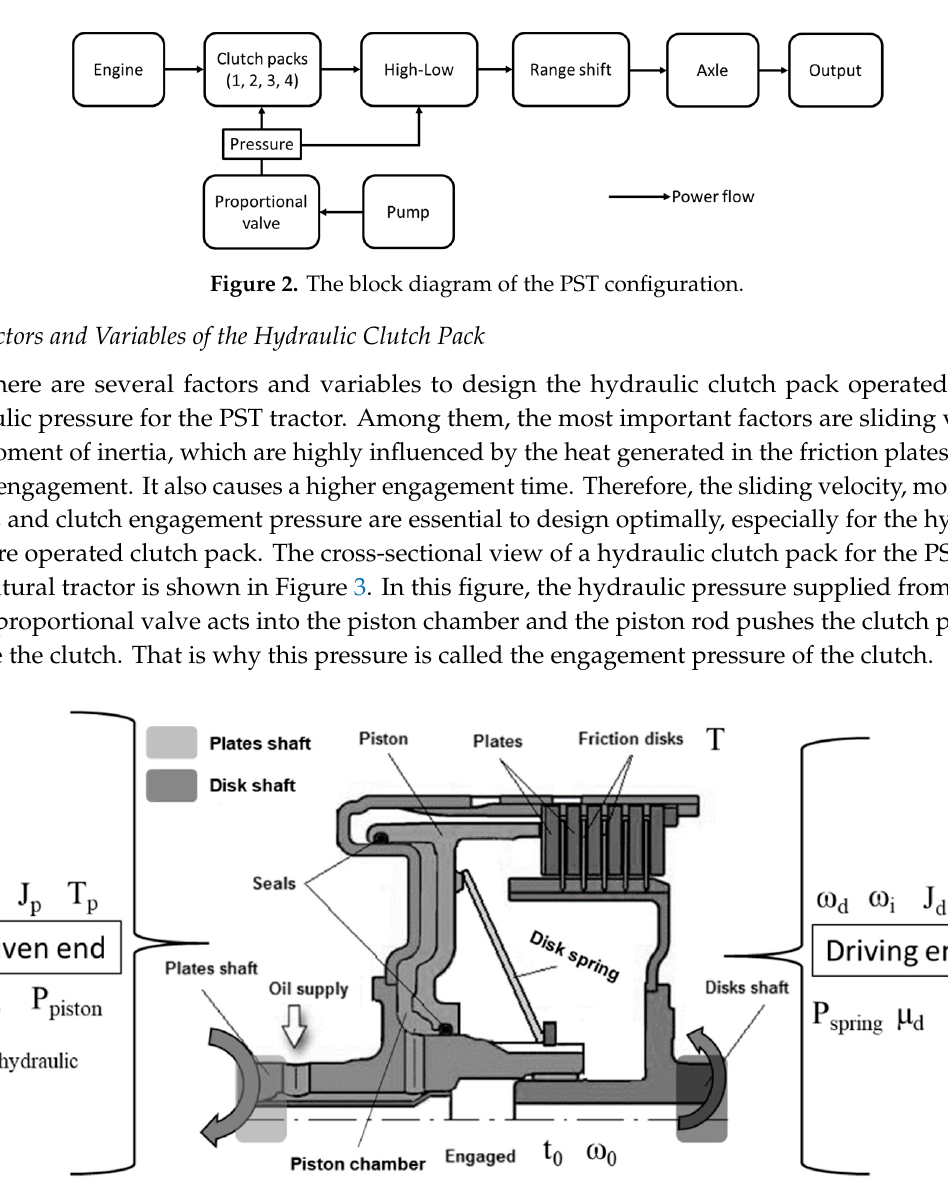
Figure 2. The block diagram of the PST configuration.